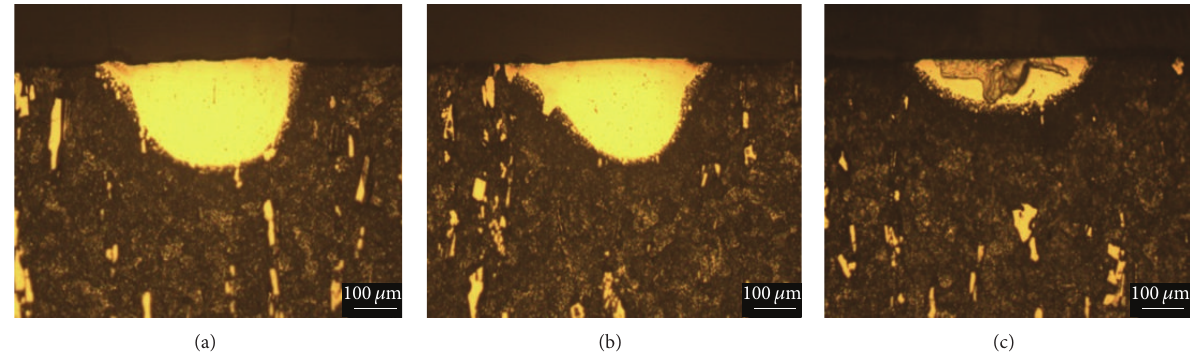
Figure 5: Cross-sectional views of a single-line bead hardened at Ar environment. Scanning rates are (a) 7.32 mm/s, (b) 14.64mm/s, and (c) 21.96 mm/sec. Laser power is constant (150